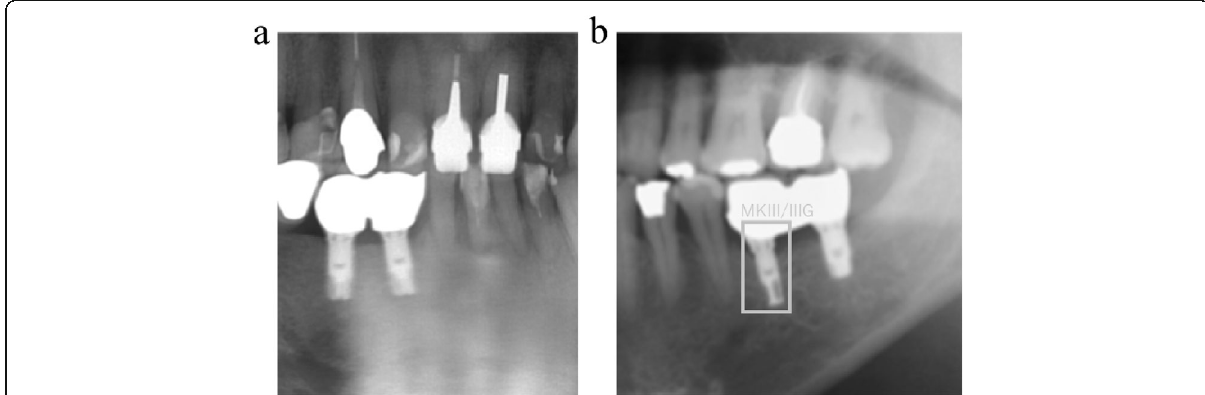
Fig. 6 Sample images of misdetected implants. a Both implants could not be detected because of the shadow of the spina. b Left implant was detected correctly as MK III/IIIG, but the right implant was not detected because of an unclear